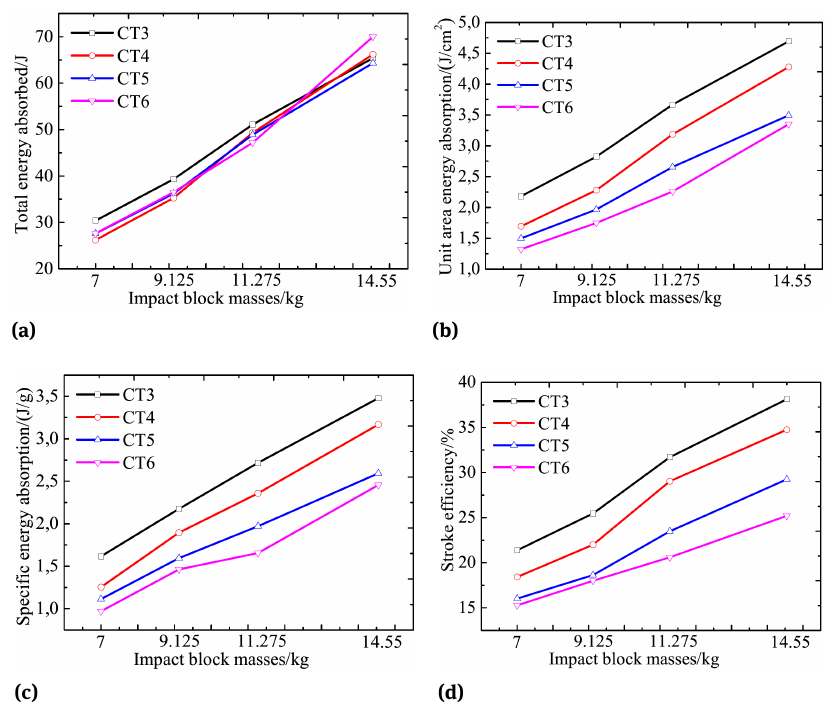
Figure 14: Cushioning energy absorption of Y-direction paper corrugation tubes at different impact block masses: (a) total energy absorp- tion, (b) unit area energy absorption, (c) specific energy absorption, (d) stroke